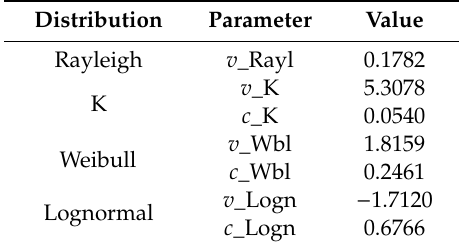
Table 2. Estimated parameters of amplitude